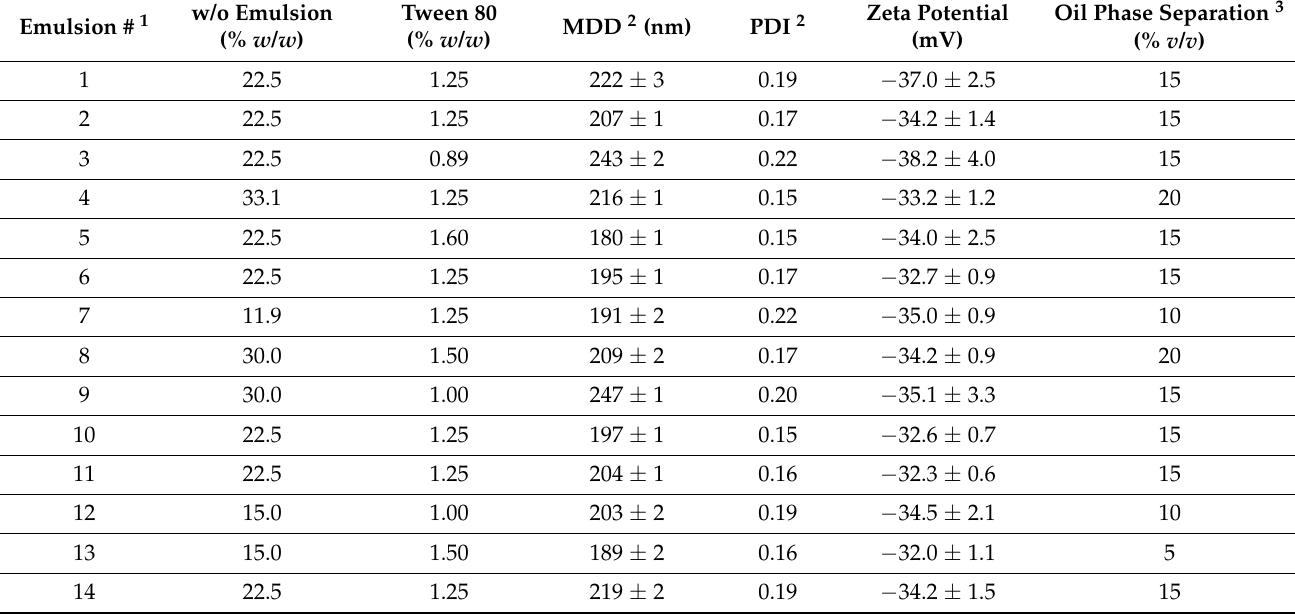
Table 1. Characterization of w/o/w nanoemulsions.